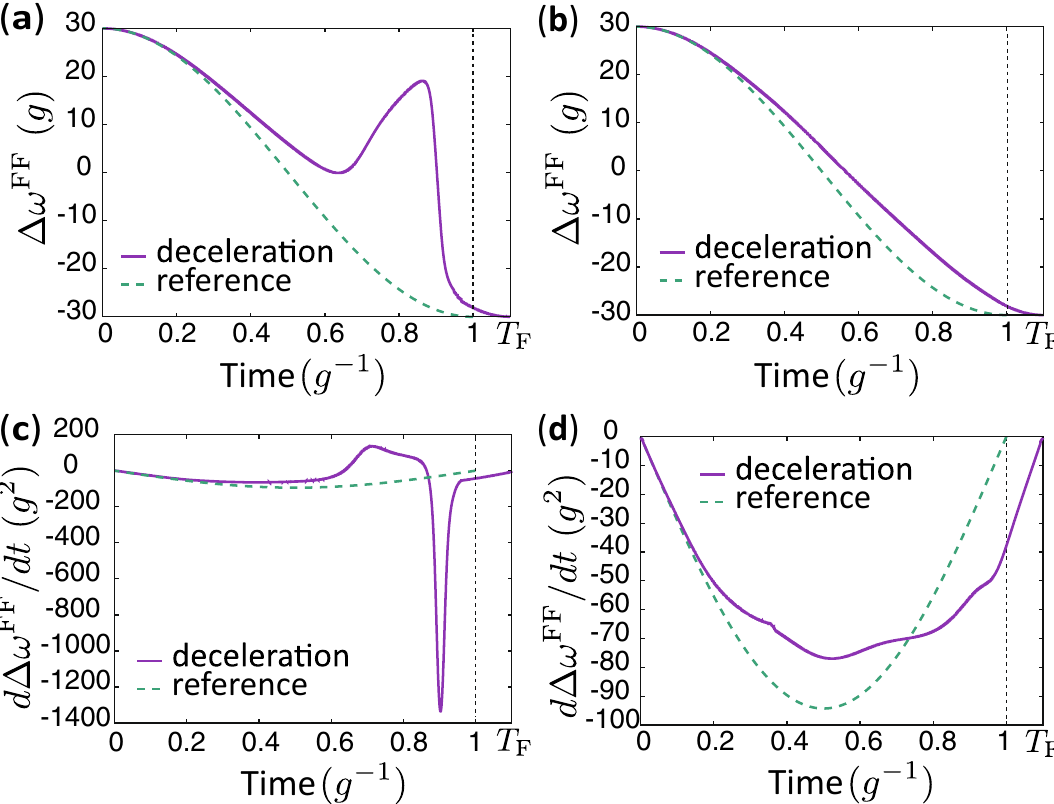
Figure 6. Difference of qubit frequencies and its time derivative. ( a,b ) Time dependence of �ω FF = ω FF 1 − ω FF 2 for the virtual trajectories. The dashed curve represents the �ω = ω 1 − ω 2 used in the reference dynamics. The parameters used are the same as in Fig. 5. ( c,d ) Time dependence of d �ω FF / dt and d �ω/ dt . ( a,c ) are for virtual trajectory A, and ( b,d ) are for virtual trajectory